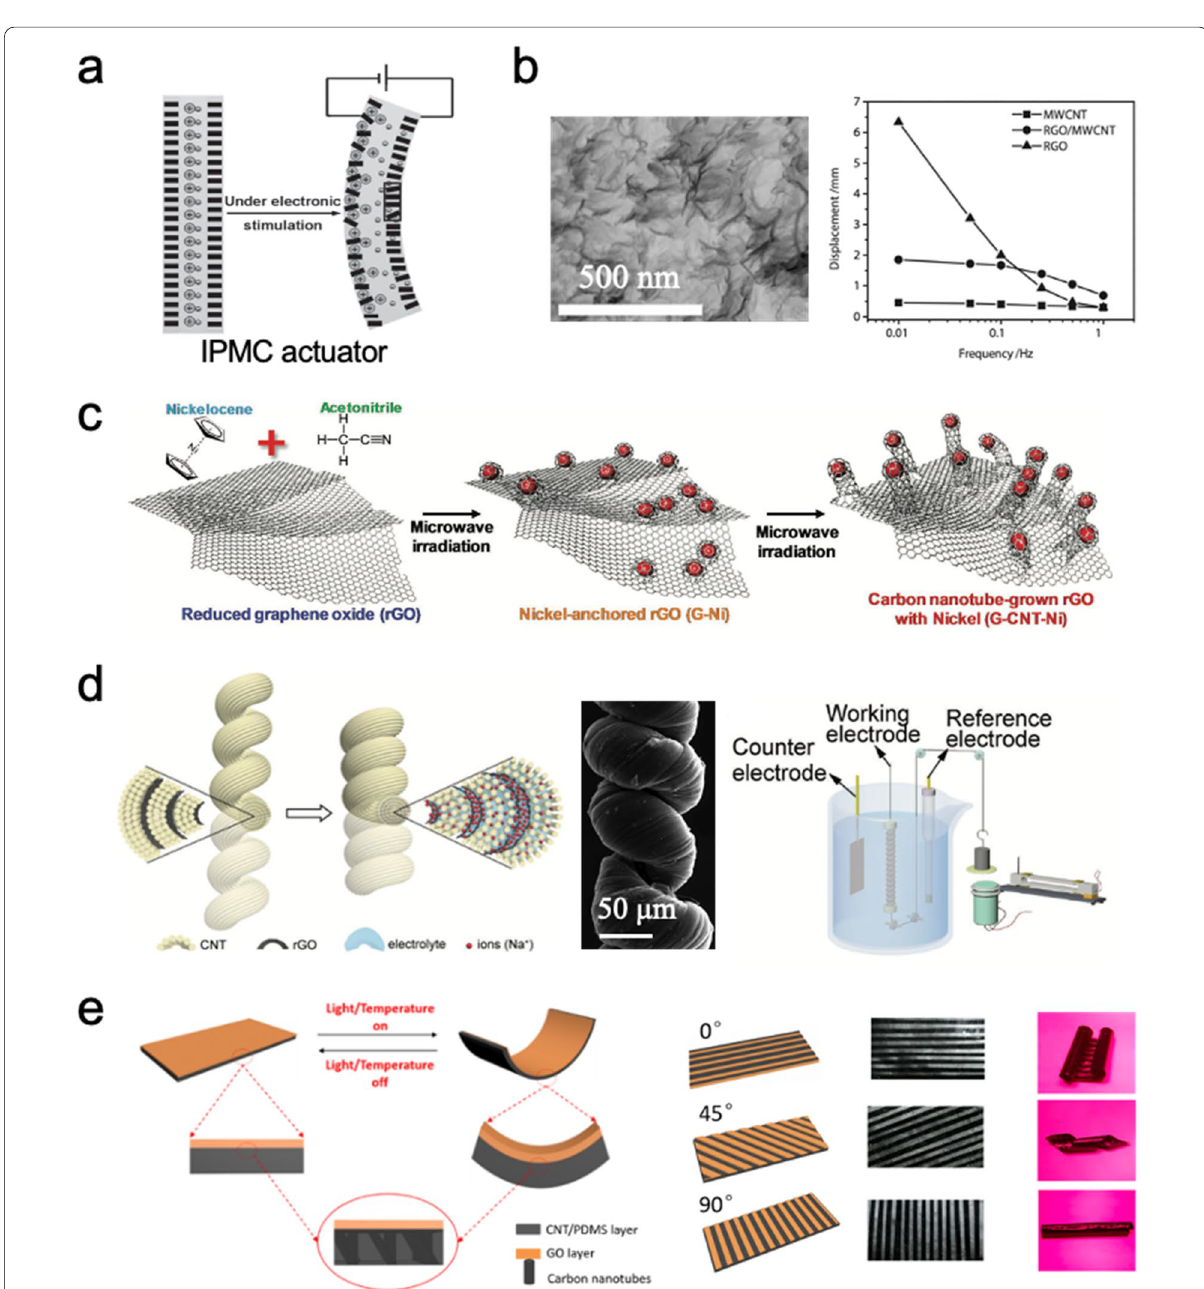
Fig. 4 a Illustration of the working mechanism of an ion polymer metal composite (IPMC) actuator. Reproduced with permission [20]. Copyright 2014, John Wiley and Sons. b Scanning electron microscope (SEM) image of rGO/MWCNT hybrid layer showing porous surface structures and displacement of bending actuation with different conductive materials over the frequency range from 0.01 to 1 Hz. Reproduced with permission [93]. Copyright 2012, John Wiley and Sons. c Fabrication process of graphene-carbon nanotube-nickel (G-CNT-Ni) heterostructures. Reproduced with permission [30]. Copyright 2017, John Wiley and Sons. d Coiled CNT/rGO hybrid yarns: a schematic diagram of the working mechanism, a SEM image showing the structure of the yarn, and an illustration of the testing setup. Reproduced with permission [94]. Copyright 2018, John Wiley and Sons. e Illustration of the bending and recovery actuation of the graphene oxide (GO)-CNT/PDMS bilayer membrane in response to light and temperature stimulations and the controlled bending behaviors with the aligned GO patterns in different directions. Reproduced with